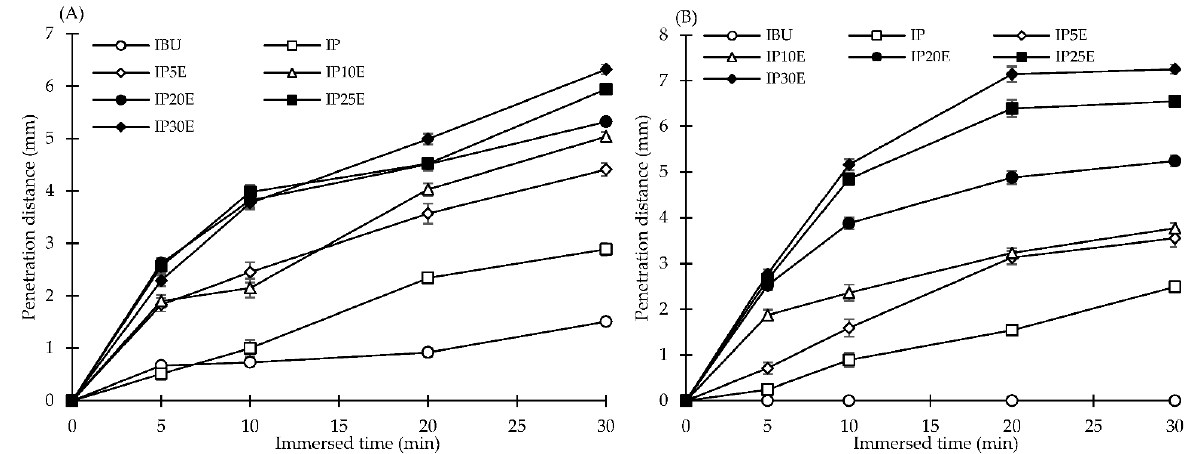
Figure 3. The penetration distance capacity of eutectic effervescent tablets in distilled water ( A ) and 0.1 N HCl buffer pH 1.2 ( B ). Table 2. Rate of wetting, gel formation, erosion and dissolution parameters of eutectic effervescent tablets in various testing